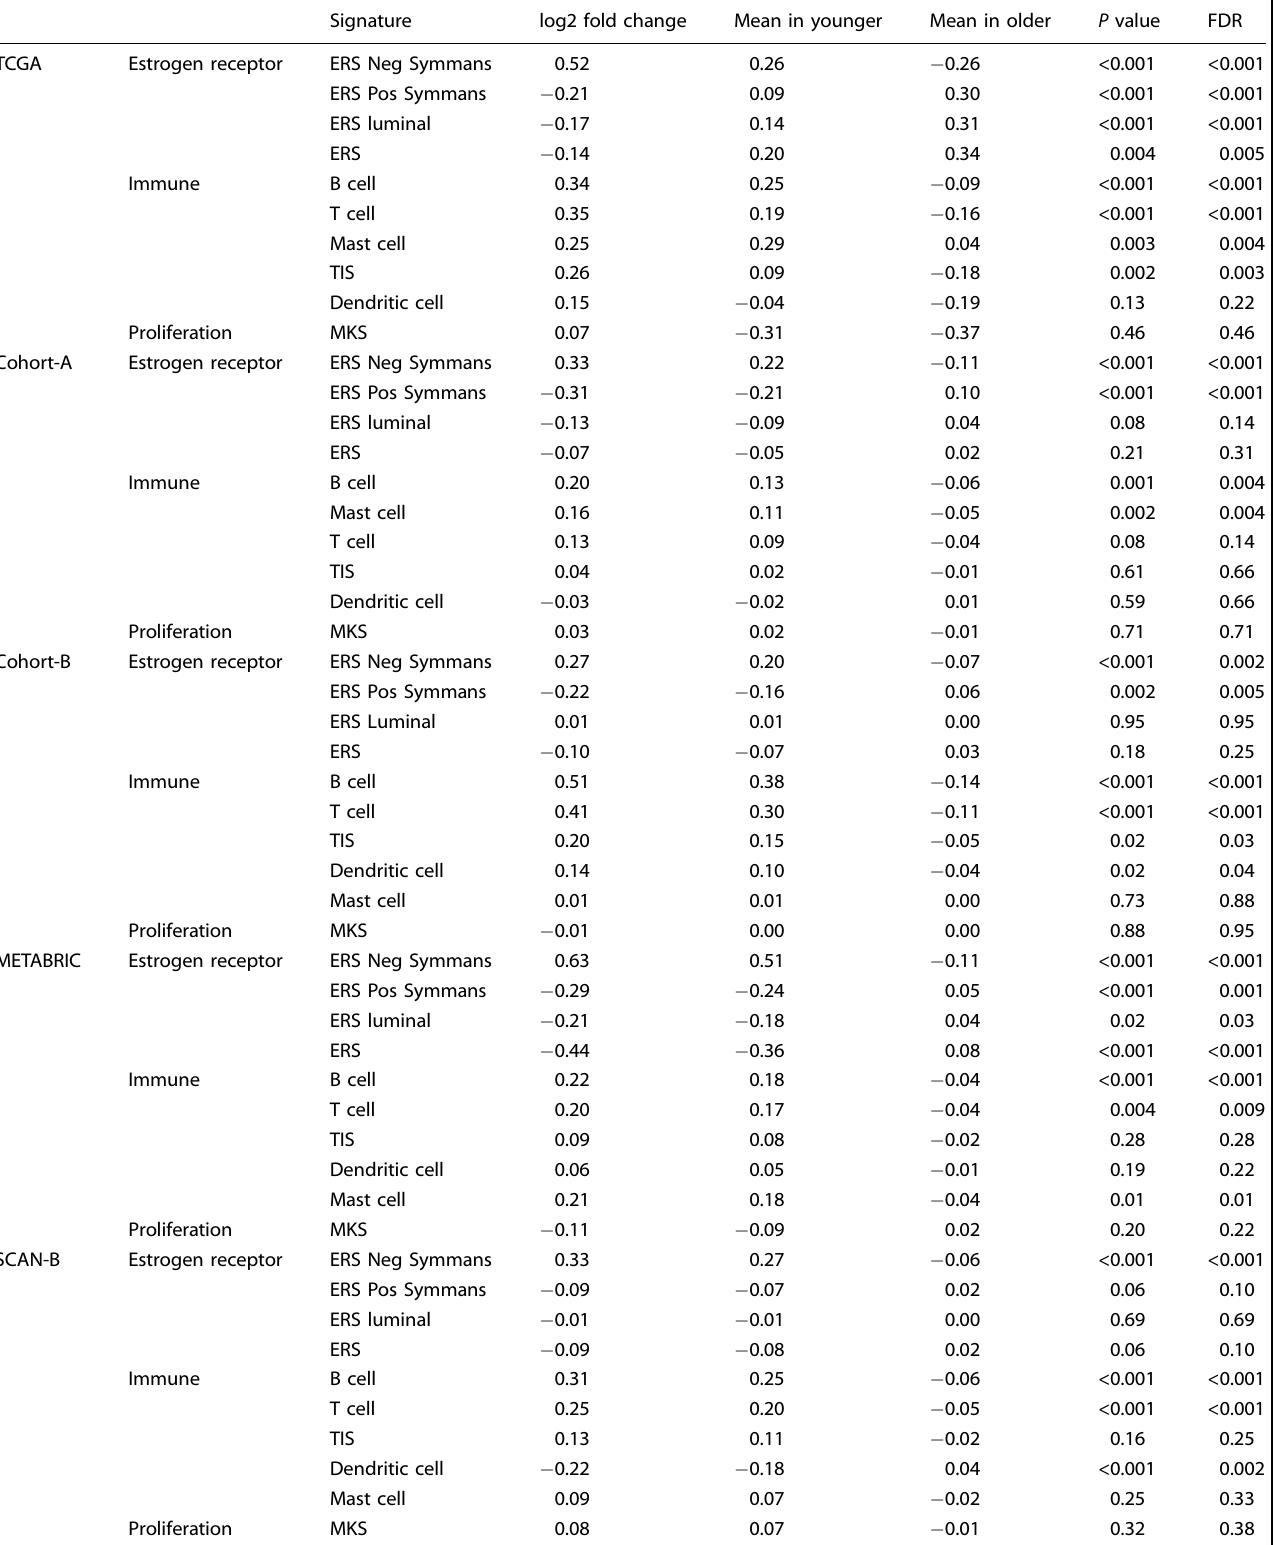
Table 2. Estrogen receptor and immune and proliferation-related signatures in younger and older breast cancer